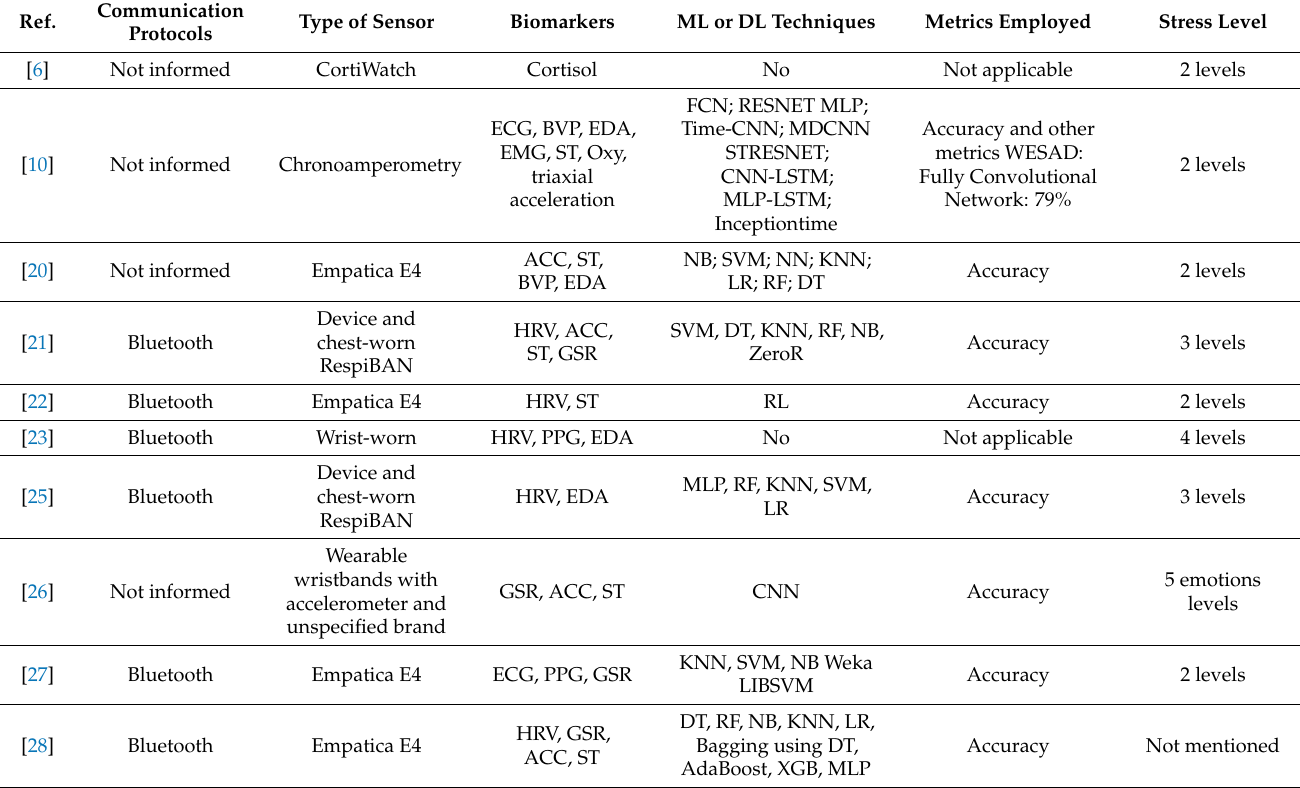
Table 3. Characteristics of studies included in the systematic